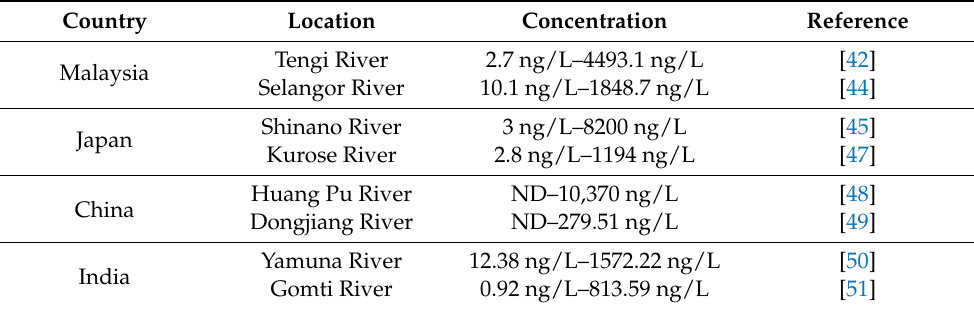
Table 7. Concentrations of pesticide in some Asian rivers reported in